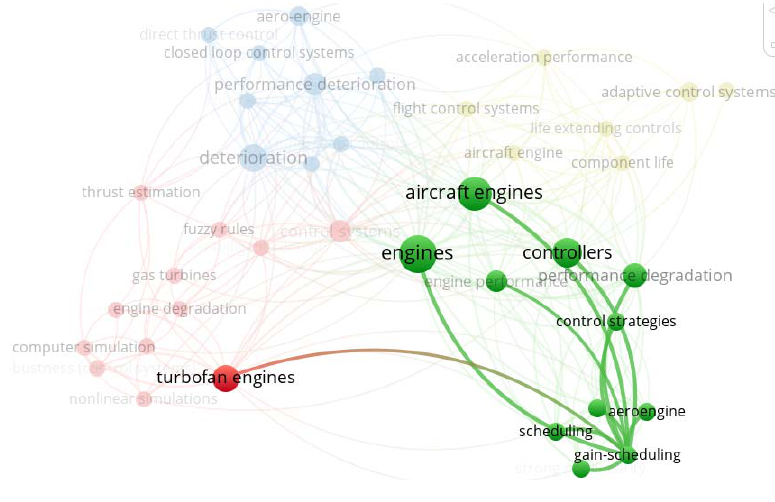
Figure 7. The thematic relationship of a group of interrelated words.